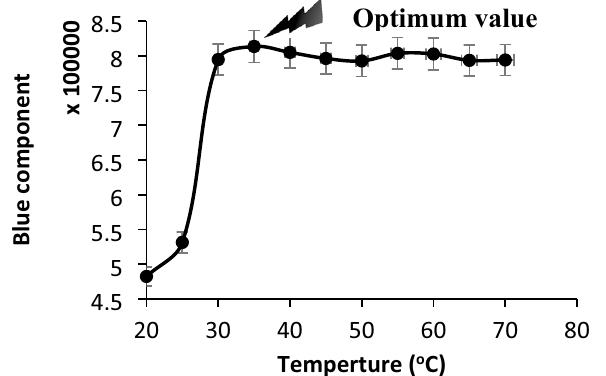
Figure 8. Optimum temperature for water vapors introduced to the analyzing system. Conditions: standard RH: 40–45%, applied voltages: 110 ± 1 V (AC, vs. GND), and pressure: 25–30 torr. The data are the average of three independent analyses. Error bar: ± relative standard deviation.